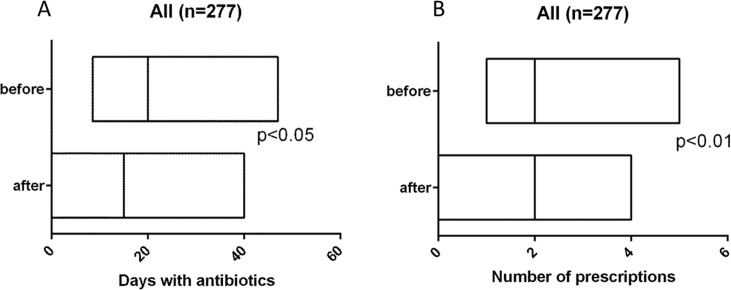
Number of days with antibiotics (A) and number of prescriptions (B) per patients the year before and after starting on vitamin D treament. The lines shows median and boxes show interquartile range. Statistical test was performed using Wilcoxon matched-pairs signed rank test.